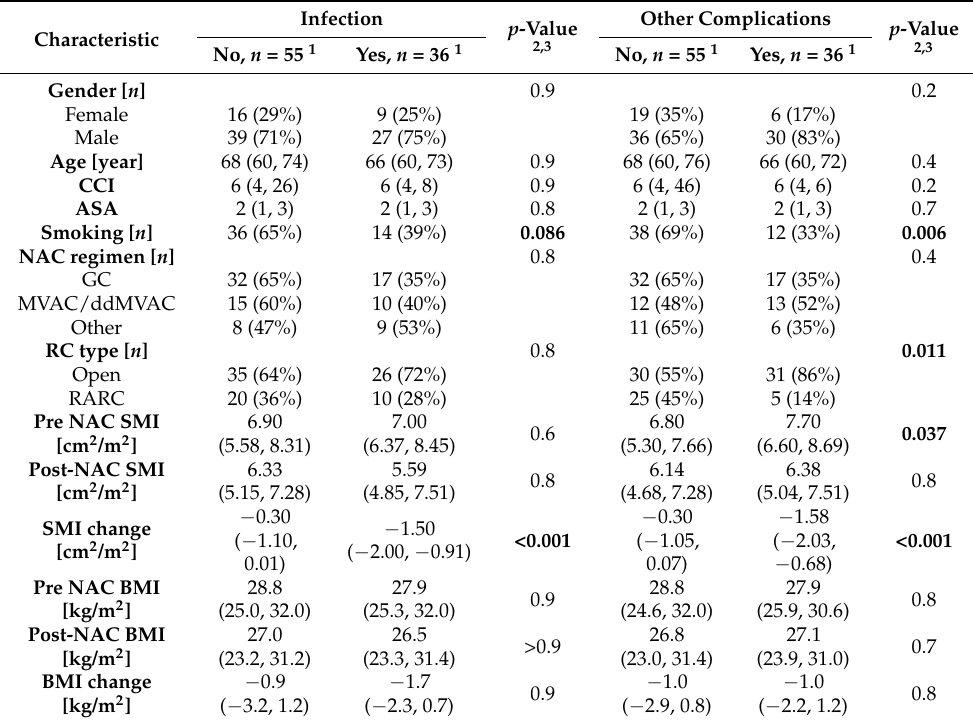
Table 3. Descriptive statistics according to infection and other